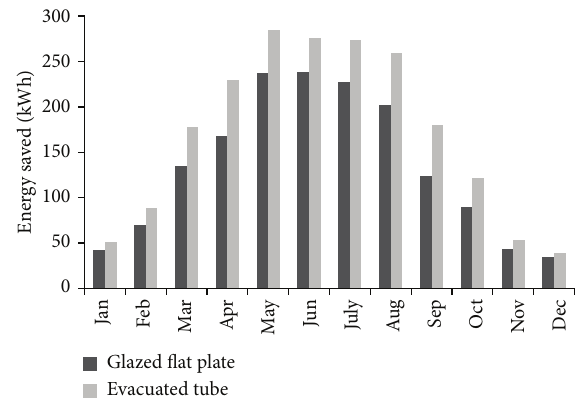
Figure 5: Annual auxiliary energy saving and solar fraction for each type of collectors.